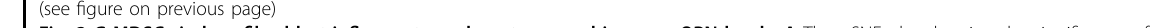
Fig. 3 G-MDSCs induce fi broblast in fl ammatory phenotypes and increase OPN levels. A The t-SNE plot showing the signi fi cance of myo fi broblasts in cardiac fi broblasts of young and aging mice based on the scRNA-seq data set(E-MTAB7869). B CCK-8 analysis shows the proliferative potential of the fi broblasts cultured alone or cocultured with G-MDSCs at 12 h and 24 h; n = 5 per groups. C , D The mRNA levels of fi brosis markers (Col3a1, Postn, Acta2; C ) and in fl ammatory cytokines (Tnf, IL6, IL10; D ) in the fi broblasts cultured alone or cocultured with G-MDSCs for 24 h analyzed by qPCR; n = 5 per group. E – H Fibroblasts were cocultured with G-MDSCs for 24 h, and anti-S100A8/anti-S100A9 (50 µg) was added to the culture to neutralize S100A8/A9 secreted by G-MDSCs. Immuno fl uorescence staining revealed the levels of OPN ( E ) and α -SMA ( F ) in fi broblasts. Scale bars, 20 μ m. G The mRNA levels of Tnf and IL6 in the fi broblasts of each group were analyzed by qPCR; n = 5 per group. H Intracellular ROS generation was analyzed by fl ow cytometry through DCFH-FA staining. Representative cytograms are shown on the top, and statistical data are shown on the bottom; n = 6 per group. The data are presented as the means ± SDs. Differences were determined by Student ’ s t test (for 2 groups) or one-way ANOVA (for more than 2 groups), and Tukey ’ s HSD post hoc test was performed. Repeated measures ANOVA was performed for time series data, and correlations were evaluated by Pearson ’ s test. * P <